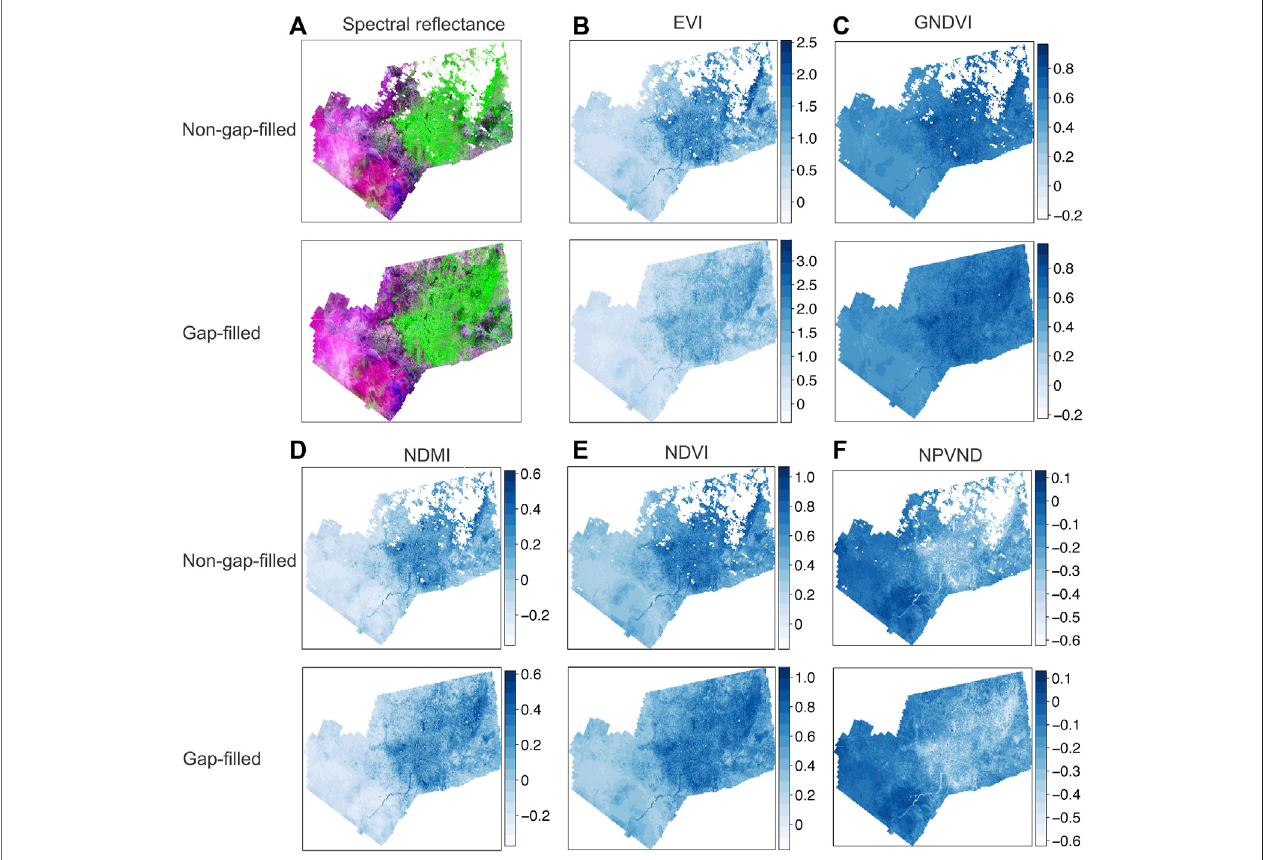
FIGURE 3 | The non-gap- fi lled and MOPSTM-gap- fi lled images and for the Landsat image acquired on DOY 14 2015. (A) Spectral re fl ectance displayed in false color of R: SWIR1, G: NIR, and B: red surface re fl ectance, (B) EVI, (C) GNDVI, (D) DNMI, (E) NDVI, and (F) NPVND. Abbreviations: EVI, enhanced vegetation index; GNDVI, green normalized differential vegetation index; NDMI, normalized difference moisture index; NDVI, normalized difference vegetation index; NPVND, non- photosynthetic vegetation normalized difference.